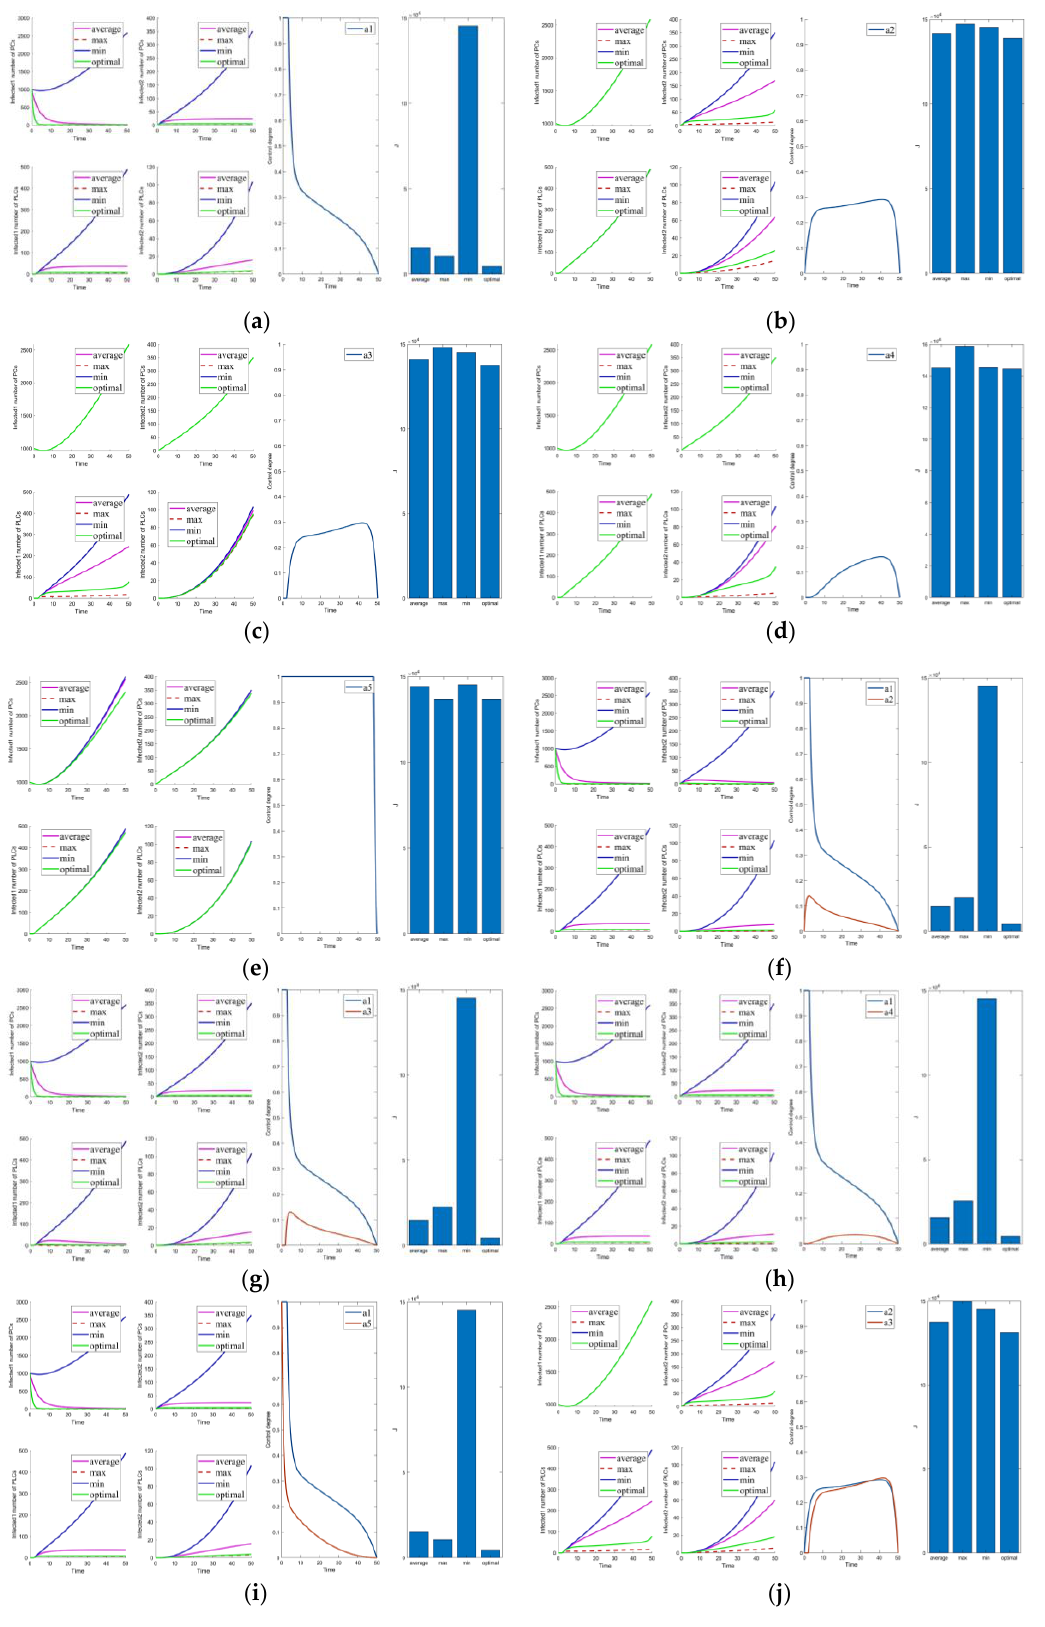
Figure 7. Solution of the optimal control strategy for Case 31 (removing average constant).